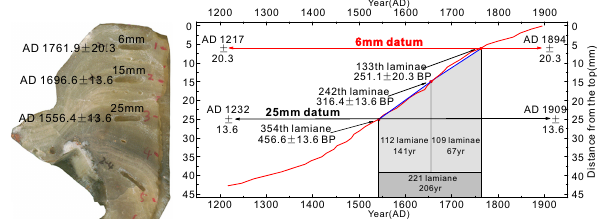
Figure 5. The age model for stalagmite ky1 established by count- ing of laminae and high-precision dating results with the U– 230 Th technique. This figure is the photo of stalagmite ky1, and the age label was based on high-precision dating results with the U– 230 Th technique on the left. The blue line is the high-precision dating re- sults with the U– 230 Th technique and the connecting lines. The red line is the age scale established by this article. The ages of other laminae were determined by annual laminae counting upward and downward based on the 133rd of the laminae corresponding to the position of 6mm. The date of which is AD1762 ± 20.3 decided by high-precision dating results with the U– 230 Th